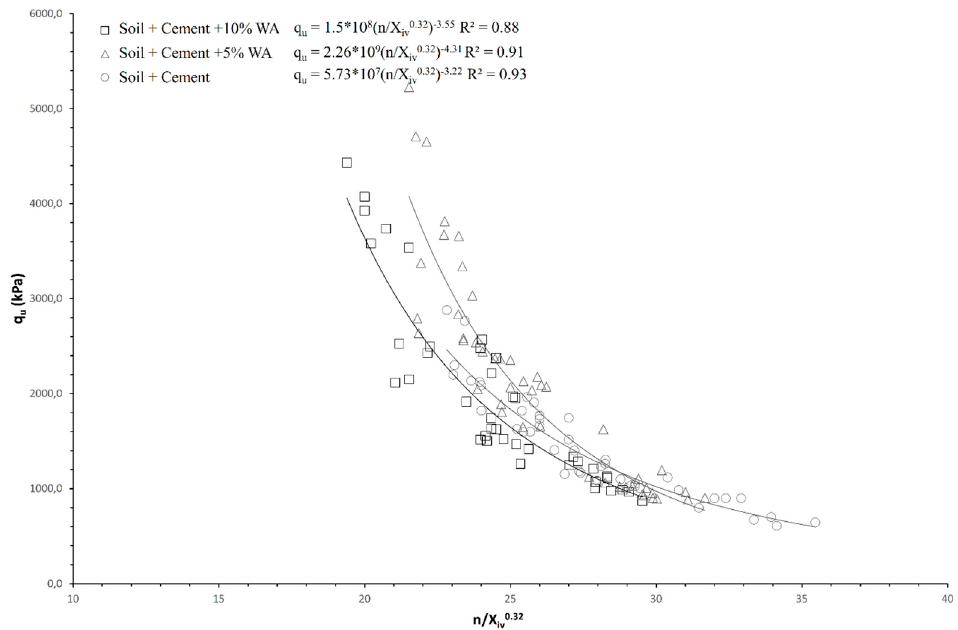
Figure 5. Variation of unconfined compressive strength (q u ) with adjusted porosity / binder index for all blends considering cement only, cement + 5% wood-ash, and cement + 10% wood-ash.